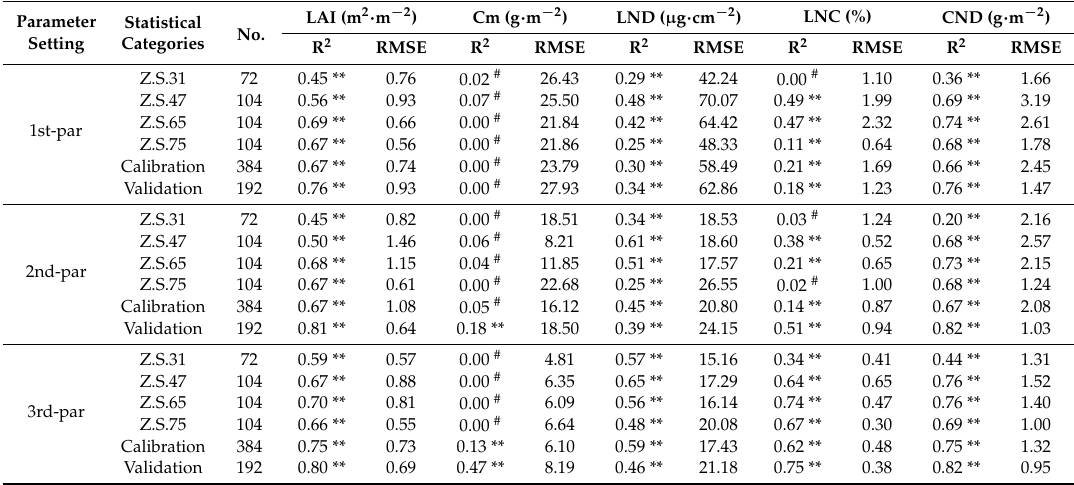
Table 7. Comparison of different agronomic parameters estimation with different parameter setting. Parameter